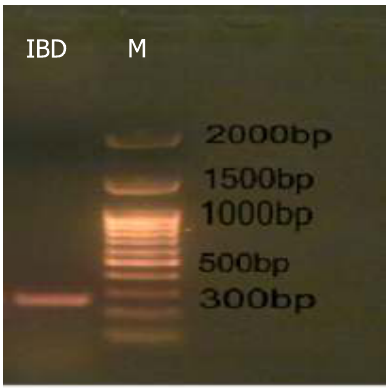
Figure-1. The PCR amplification of the spike gene of IBD polymerase gene under test. The amplification of the 300bp fragment of vp gene of IBD virus indicated that IBD viral DNA was present